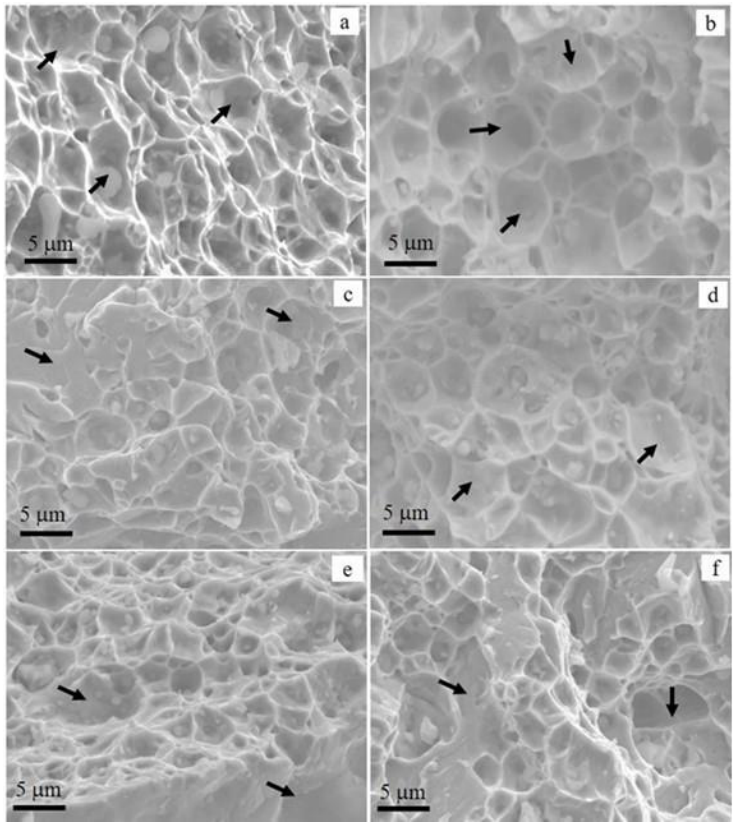
Figure 15. SEM image showing the fracture morphology of ( a ) AP ( b ) DA, ( c ) H1A, ( d ) H2A, ( e ) 511 H1Q, and ( f ) H2Q. 512